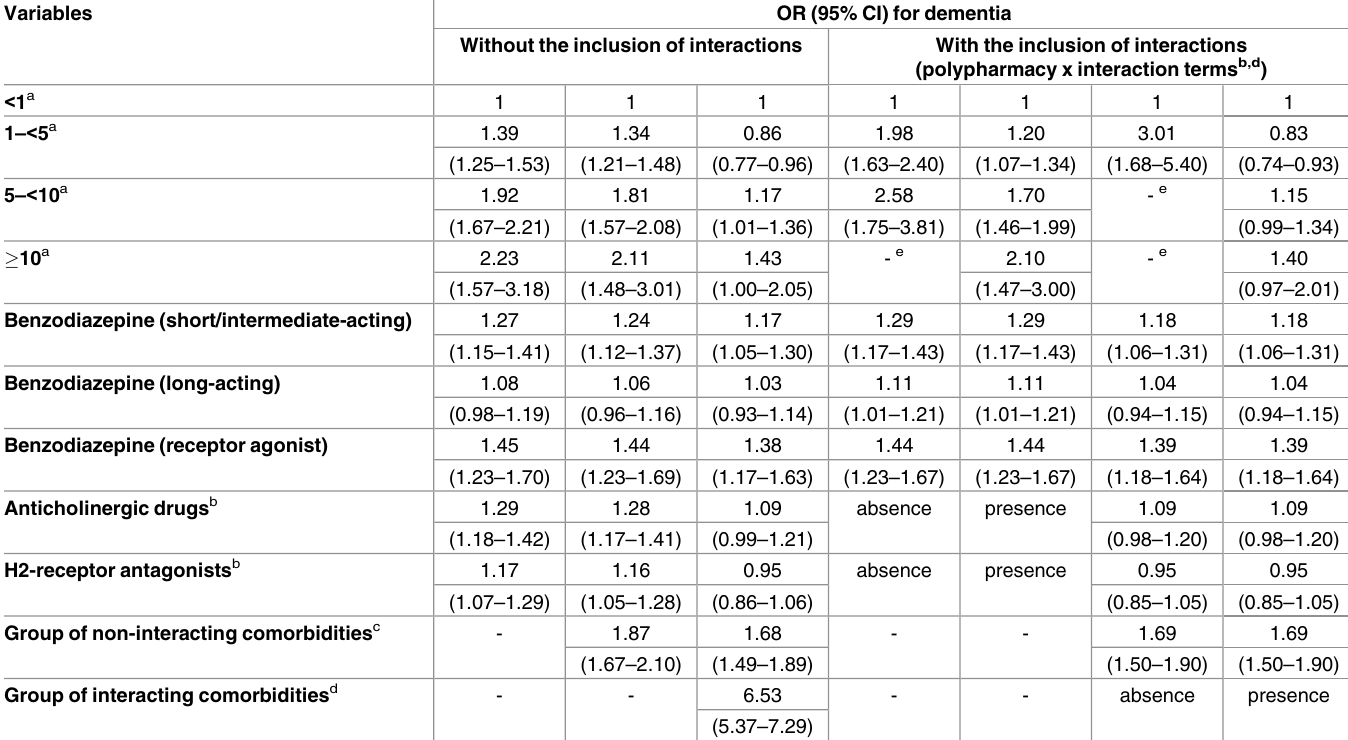
Table 4. Multivariable logistic regression analysis with or without interaction